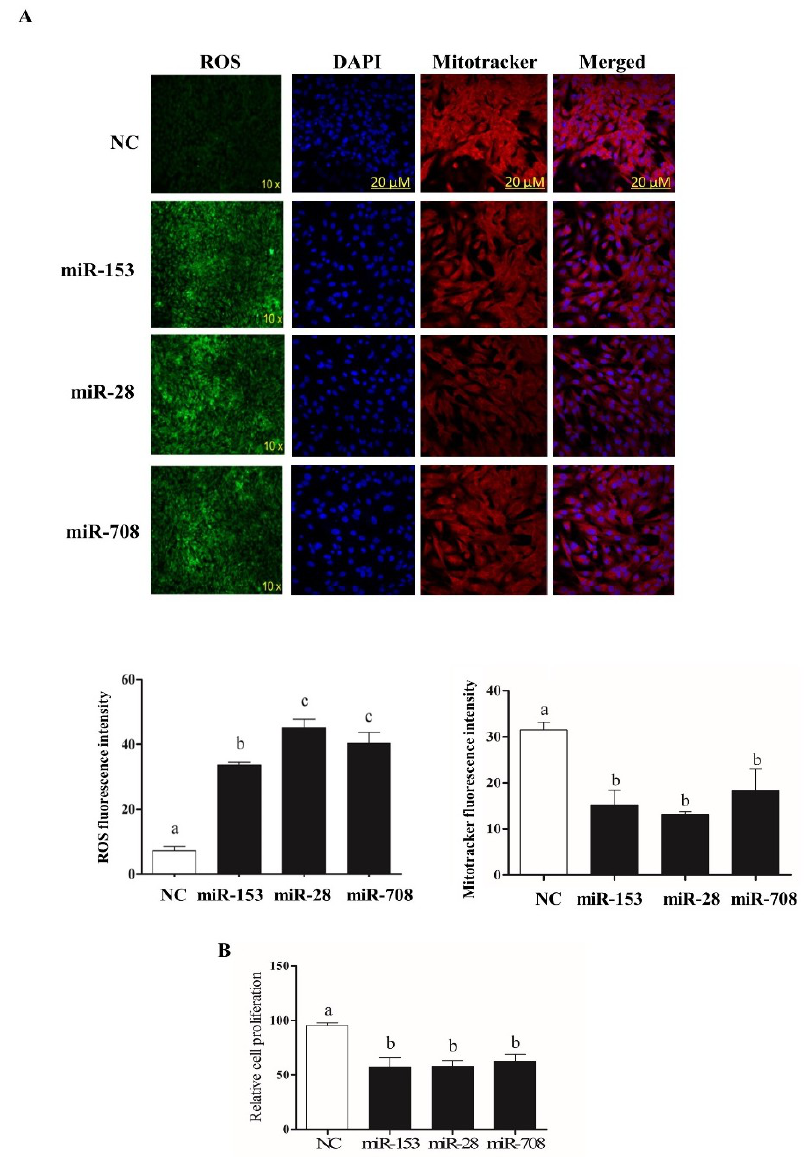
Figure 3. Higher level of intracellular Reactive oxygen species (ROS) level accompanied with lower mitochondrial activity in bovine granulosa cells co-transfected with miR-153, miR-28 and miR-708 ( A ). Moreover, overexpression of miR-153, miR-28 and miR-708 resulted in reduced bovine granulosa cell proliferation ( B ). White bar indicates the proliferation rate of the negative control and black bars represent proliferation rate of cells co-transfected with miRNA mimics. Data are presented as mean ± SEM of three independent biological replicates. Bars with different letters (a,b) showed statistically significant differences ( p < 0.05).2.5. Selective Knockdown of Bovine Nrf2 Impaired Bovine Granulosa Cell Functions.